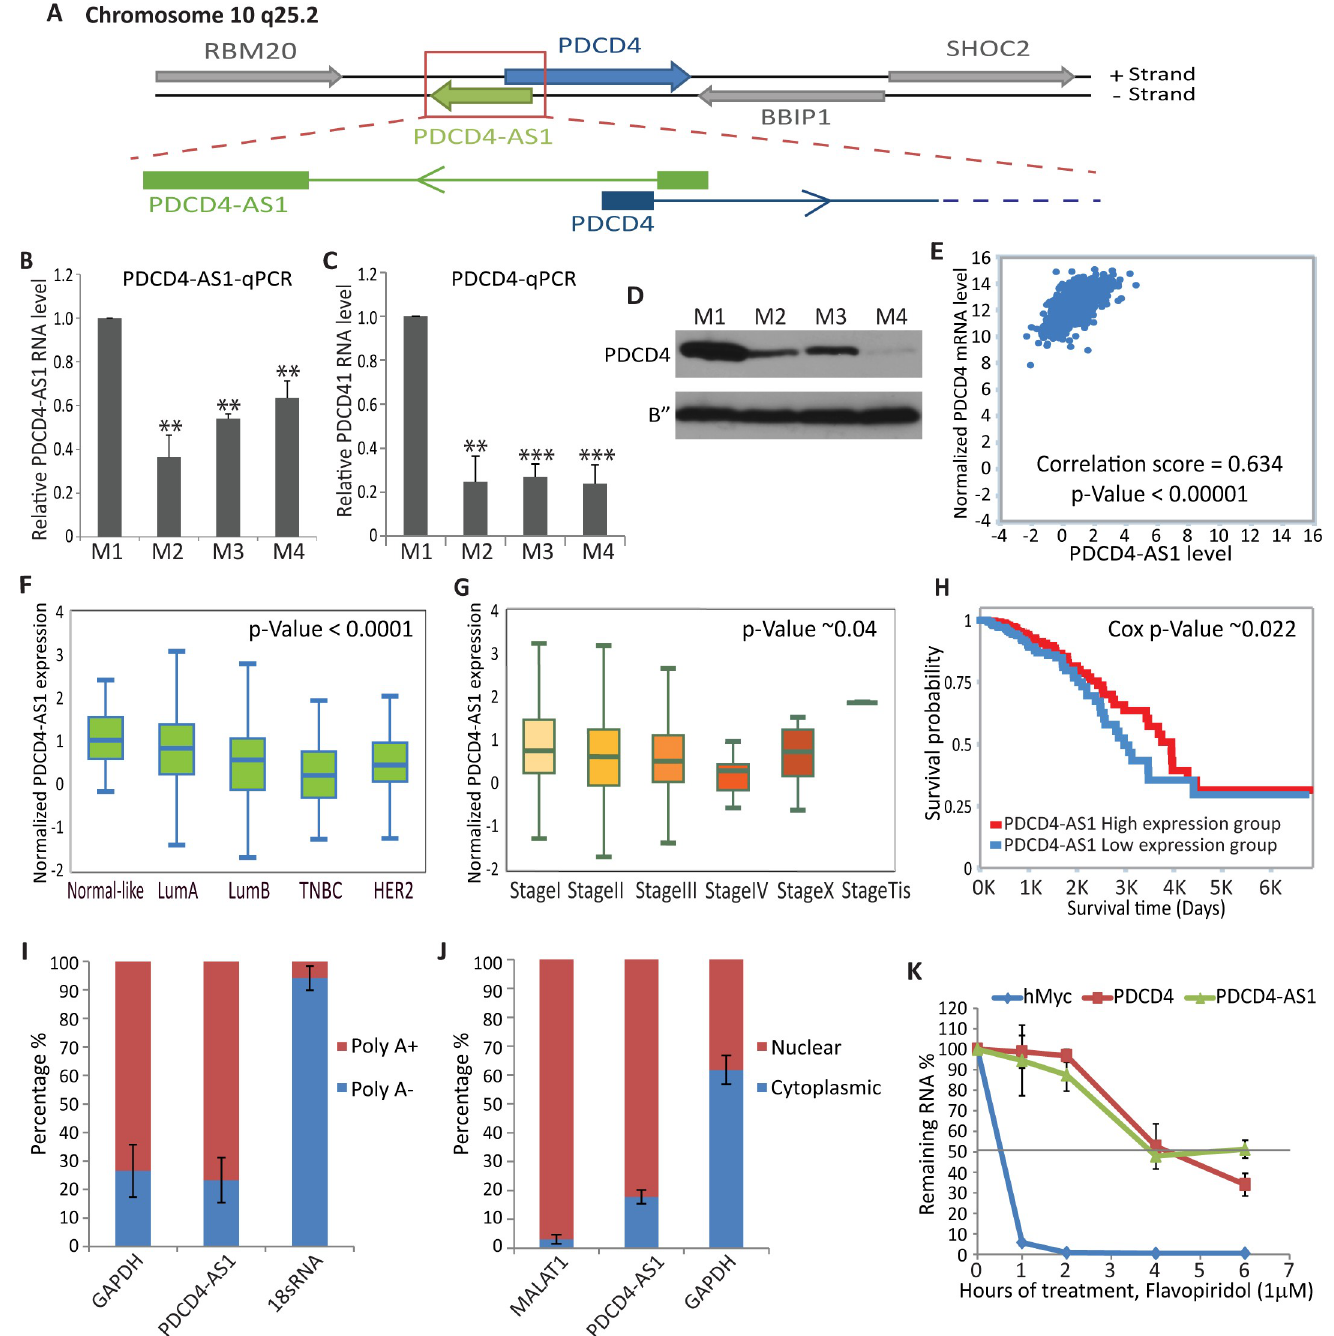
Fig 2. PDCD4-AS1 is a stable nuclear-enriched lncRNA that shows concordant pattern of expression with its coding partner PDCD4 . A) Schematic representation of PDCD4/PDCD4-AS1 gene locus. B) PDCD4-AS1 RNA level measured by RT-qPCR in M1- M4 TNBC cells. C) PDCD4 mRNA level measured by RT-qPCR in M1- M4 TNBC cells. D) Immunoblot analysis shows the relative levels of PDCD4 protein in M1- M4 cells. E) Correlation analysis between PDCD4 and PDCD4-AS1 RNA in TCGA breast cancer dataset, analyzed by TANRIC platform. F) PDCD4-AS1 RNA level in different subclasses of breast cancer patients, analyzed by TANRIC platform. G) PDCD4-AS1 RNA level in different stages of breast cancer patients analyzed by TANRIC platform. H) Kaplan–Meier analysis to depict the survival rate in TCGA breast cancer patients with high and low levels of PDCD4-AS1 , analyzed by TANRIC platform. I-J) RT-qPCR analyses in poly A + and poly A - (I) and nuclear and cytoplasmic fractionated RNA (J) from M1 cells. K) RT-qPCR to quantify the stability of PDCD4-AS1 and PDCD4 mRNA using RNA from M1 cells treated with Flavopiridol (1M) for indicated time points (0, 1,2,4 and 6 hrs). Error bars in (B, C, J & K) represent mean ± SEM of N � 3 independent experiments (biological replicates). � P < 0.05, �� P < 0.01 and ��� P < 0.001 using Student’s t test.